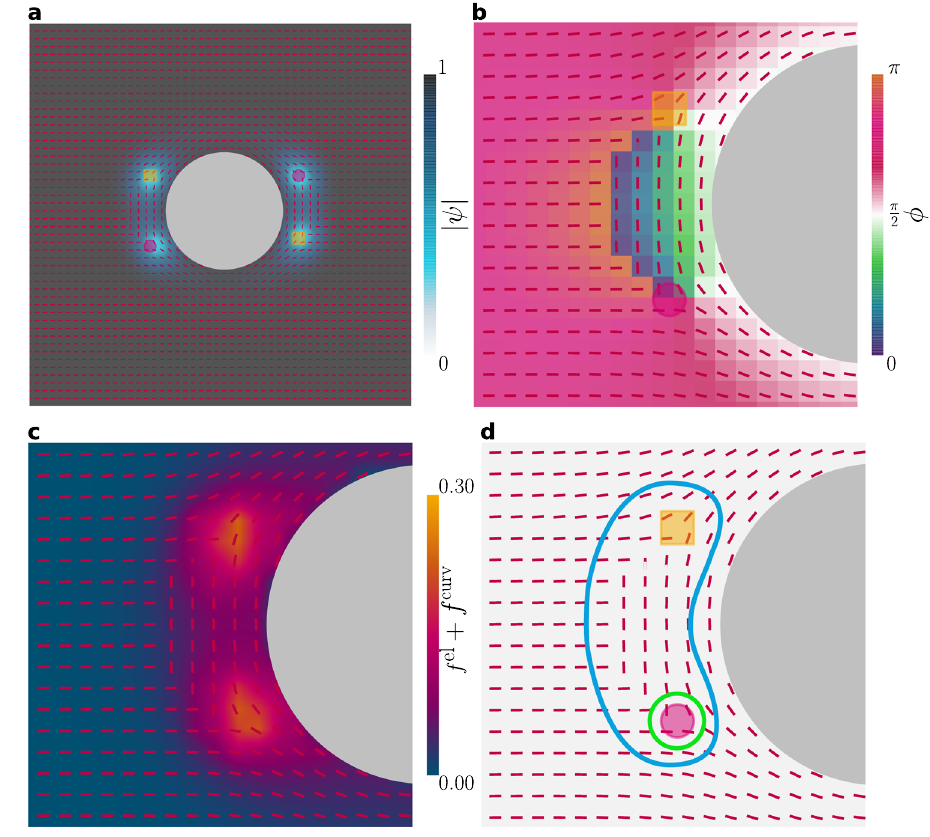
Fig. 5 | Half-charge disclinations can split into quarter-charge points at the ends of a grain boundary. Same as Fig. 4, except the phase fi eld is initialized to have one value at the surface of the inclusion ( ϕ surface = π /2) but a signi fi cantly different value in the bulk ϕ bulk ≃ 3 π /4. This results in a grain boundary, with end- pointsof − 1/4topologicalcharge.With N overlaidoneachplot. a Modulus ∣ ψ ∣ fi eld. b Phase ϕ fi eld. Zoom showing that the layer normal direction turns by π /2 across